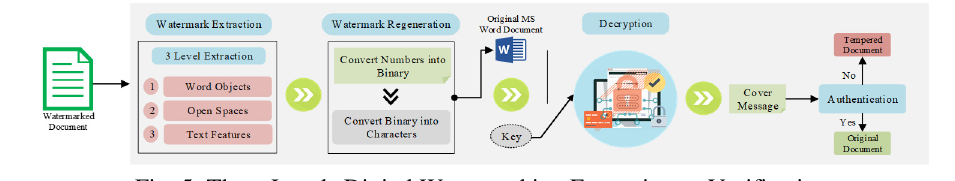
Fig. 5: Three Levels Digital Watermarking Extraction or